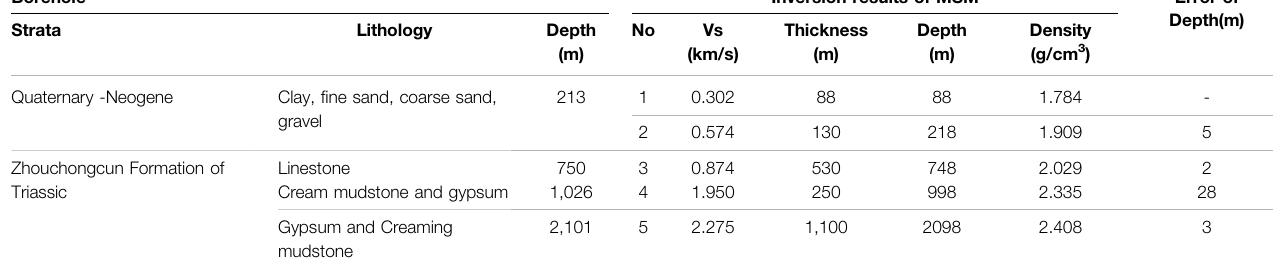
TABLE 1 | Comparison between the inversion result and borehole materials. Borehole Inversion results of MSM Error of